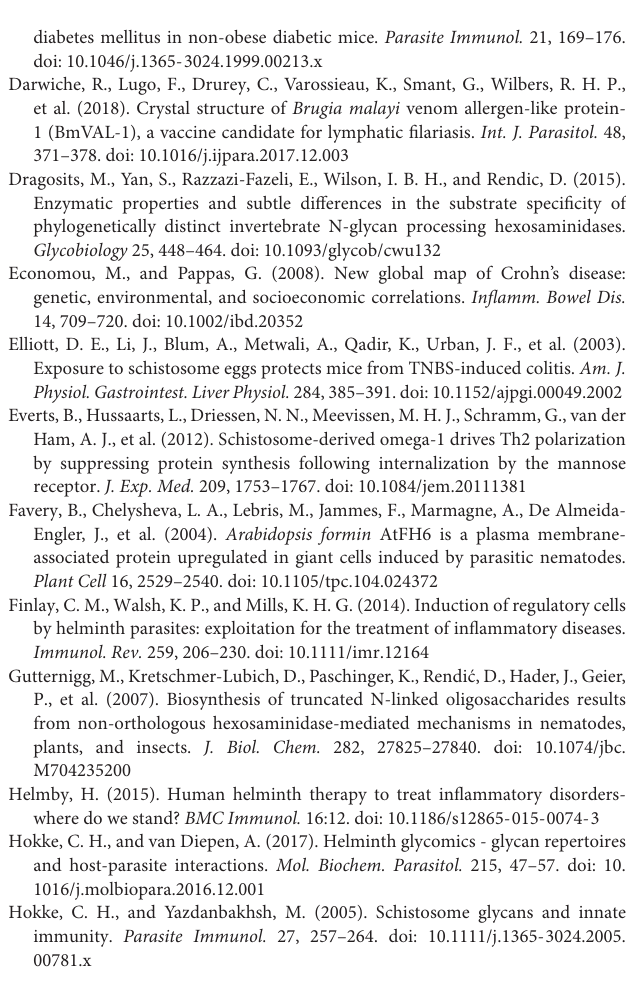
Supplementary Table 1 | Primer overview. This table gives an overview of all the primers used in this study to perform 3 (cid:48) RACE for HEXO2 orthologs and amplification of full-length HEXO open reading frames. Restriction sites used for subcloning are underlined. Capital letters refer to gene specific sequences. Supplementary Table 2 | Overview of β -Hexosaminidases. This table gives an overview of HEXO sequences from Arabidopsis thaliana and Nicotiana benthamiana reported in literature and from this study. For each HEXO variant we provide the accession number, homology between the two plant species, information on whether the gene encodes a functional protein, size of the encoded protein, presence of a signal peptide for secretion (SP) and/or transmembrane domain (TMD), the cellular localisation, and literature citations. Sequence homology between Arabidopsis and Nicotiana orthologs was determined on amino acid level by using Clustal Omega alignments. The signal peptide was predicted by the SignalP server (v5) and the transmembrane domain was predicted by the TMHMM server v2.0. Y: yes; N: